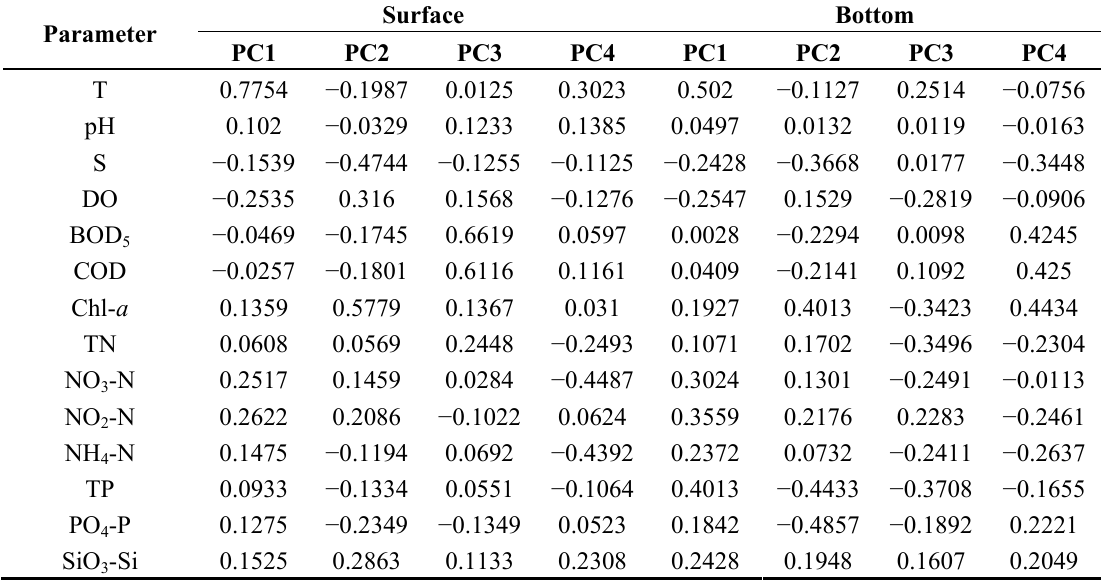
Table 1. Loadings of water quality parameters on the first four